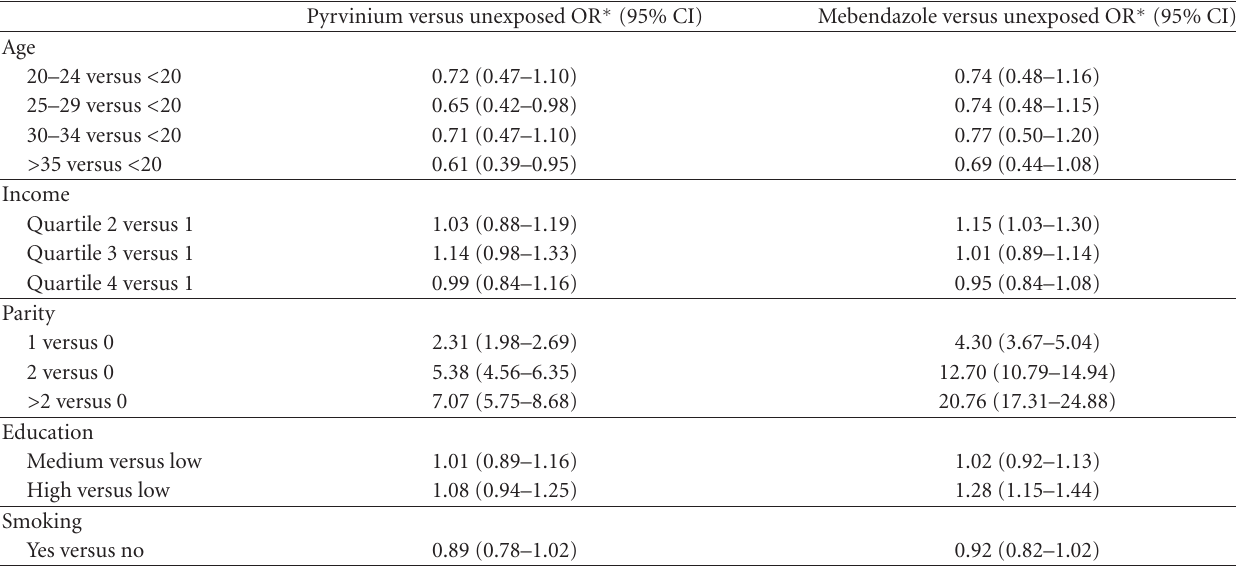
Table 2: Predictors of exposure to pyrvinium and mebendazole during pregnancy expressed by odds ratios (OR) and 95% confidence intervals